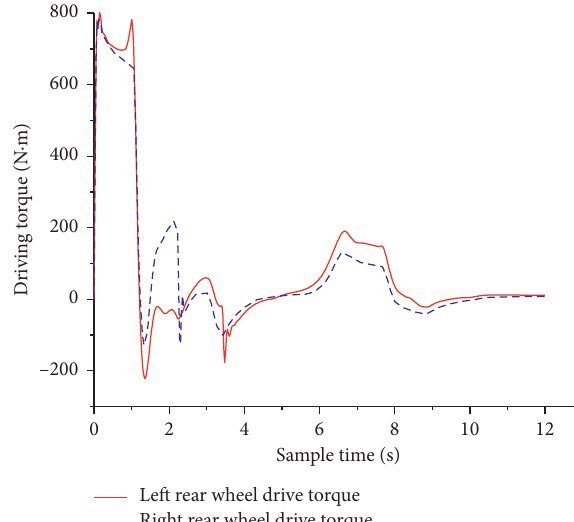
Figure 19: Left and right driving torque simulation diagram.